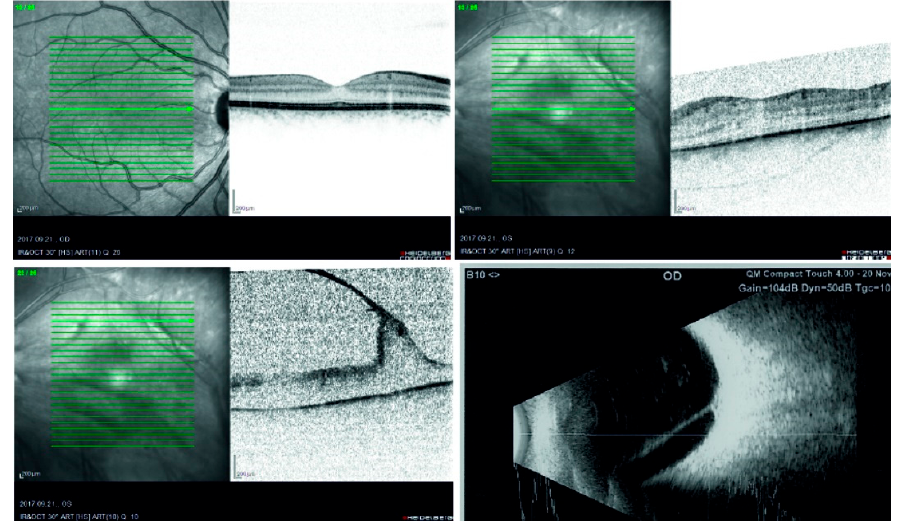
Figure 1. Preoperative optical coherence tomography (OCT) and ultrasound B-scans. The top left scan shows the normal macula of the right eye, and on the top right, the slightly thicker macula, flattened foveal depression, and a faint epimacular membrane of the left eye can be seen. The bottom left OCT and the bottom right ultrasound image demonstrate one of the tractional membranes in the left eye.